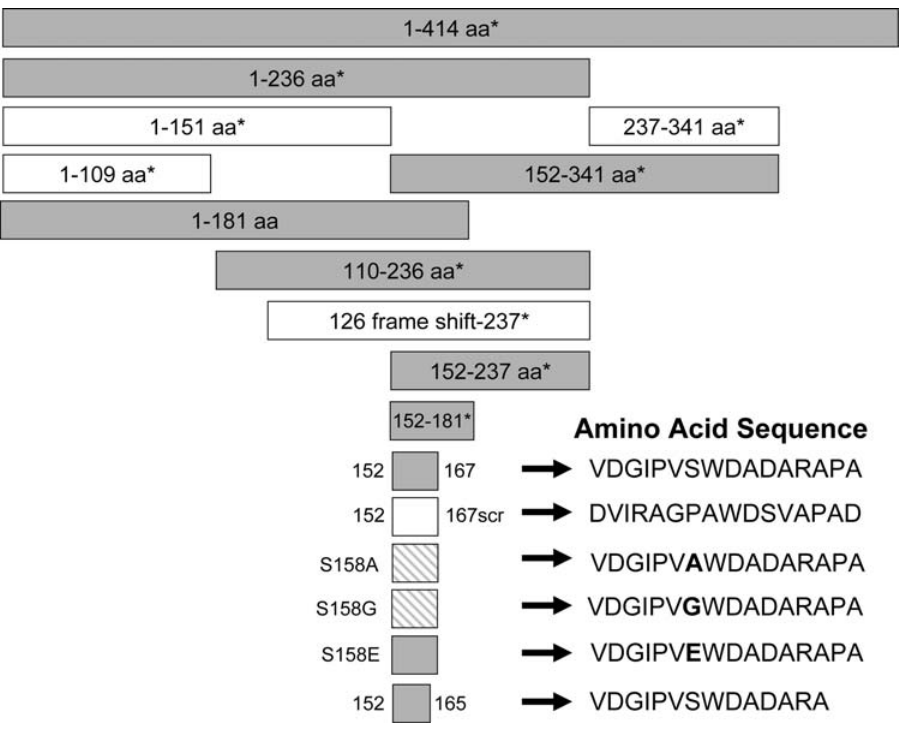
Figure 1. Summary of GBV-C NS5A proteins stably expressed in Jurkat – Tet-off cells. Boxes represent the amino acid region of GBV-C NS5A expressed in cloned Jurkat cell lines. Full length NS5A is 414 amino acids in length (1–414). The 126 frame-shift-237 contains GBV-C NS5A sequences that normally encodes these amino acids in the NS5A protein; however, a plus 1 frame shift was introduced so that the cells encode 26 missense amino acids. The amino acid sequence is shown for the 16mer peptide (152–167) and mutant peptides. Shaded boxes indicate cell lines in which HIV replication was inhibited compared to vector controls. Boxes with cross-hatches represent cell lines that inhibited HIV replication compared to controls, but significantly less than those cells indicated by solid shading. *=cell lines described previously.